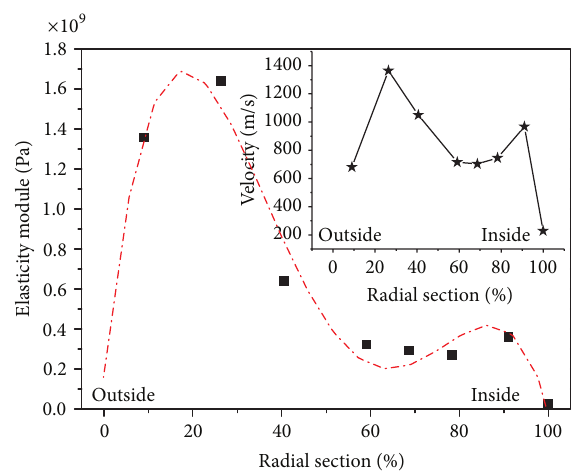
Figure 4: Elasticity modulus and velocity of the GAKVB as a function of radial section percentage.